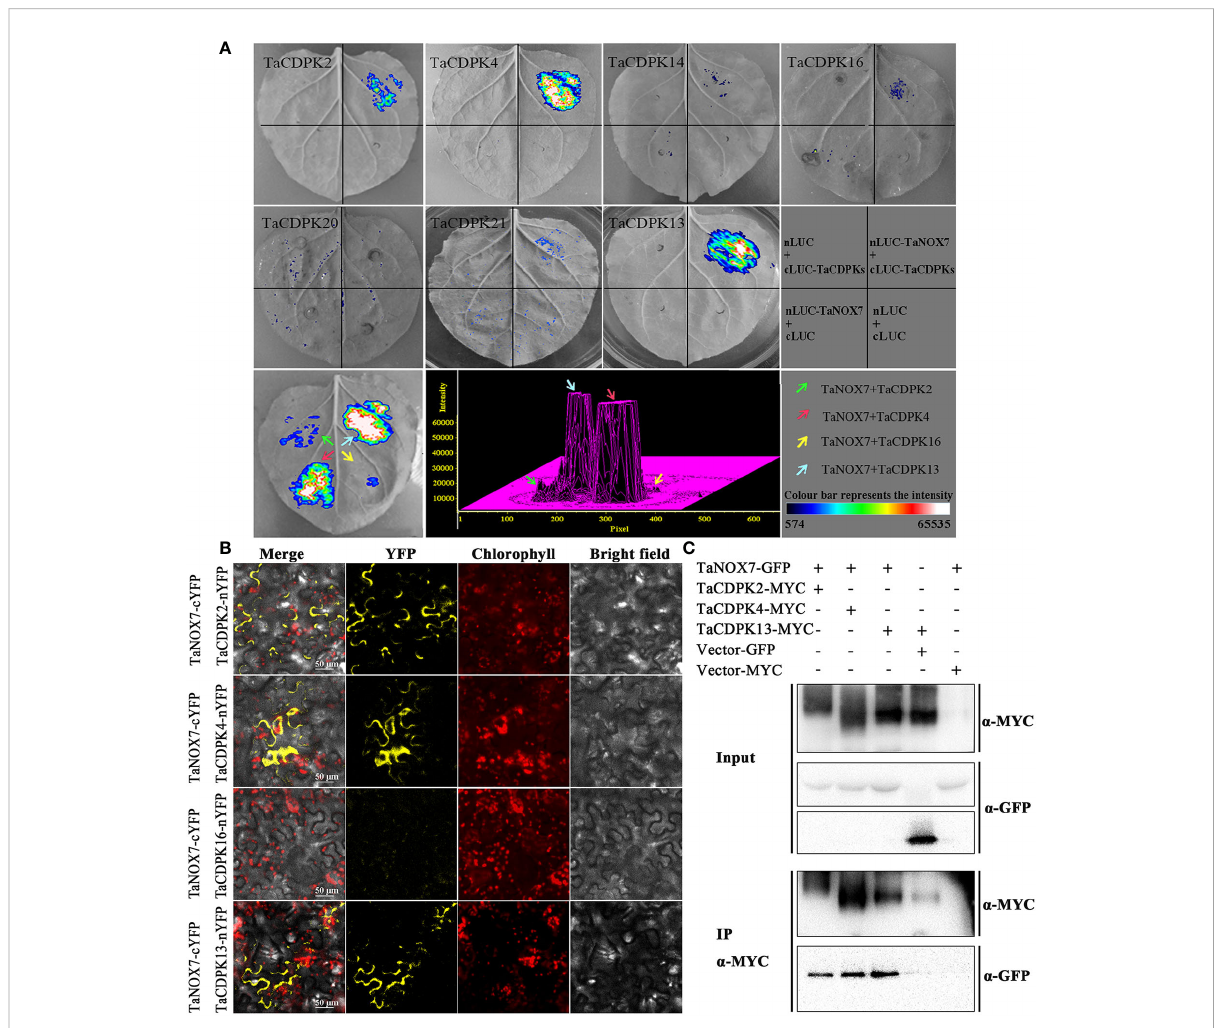
FIGURE 7 Protein interactions between TaCDPKs and TaNOX7. (A) Veri fi cation of protein interactions between TaCDPK2/4/14/16/20/21 and TaNOX7 were performed using the method of fi re fl y luciferase complementation imaging (LCI) assay; (B) Bimolecular fl uorescence complementation (BiFC) assay showing the interactions between TaCDPK2/4/16 and TaNOX7. (C) The interactions between TaCDPK2/4 and TaNOX7 were con fi rmed using the assay of co-immunoprecipitation (Co-IP), in which input and immunoprecipitates were analyzed by immunoblotting using anti-GFP and anti-MYC